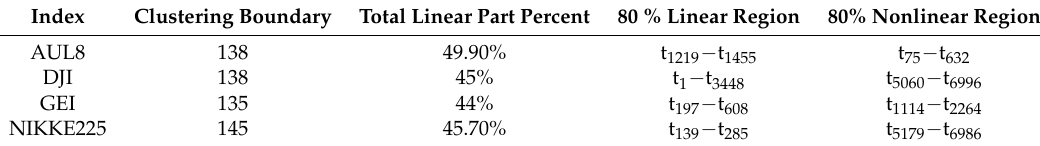
Figure 6. SOM neighbor weight distances for four datasets: ( a ) AUL8, ( b ) DJI, ( c ) GEI and ( d ) NIKKE225. Table 2. Clustering segment boundary and the division of trend to linear or nonlinear regions.